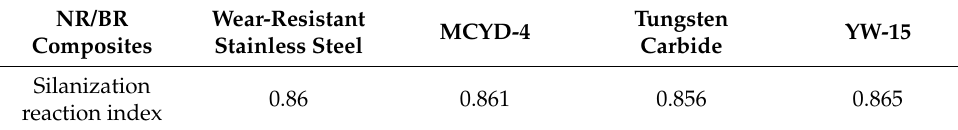
Figure 8. Degree of silanization reaction. Table 8. Silanization reaction index of NR/BR composites after friction with different metals.